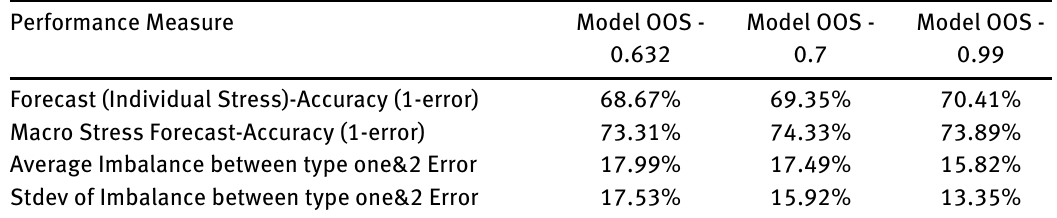
Table 5: Summary of out of sample results for different sizes of the stress sample. The measures are shown in % of the underly- ing